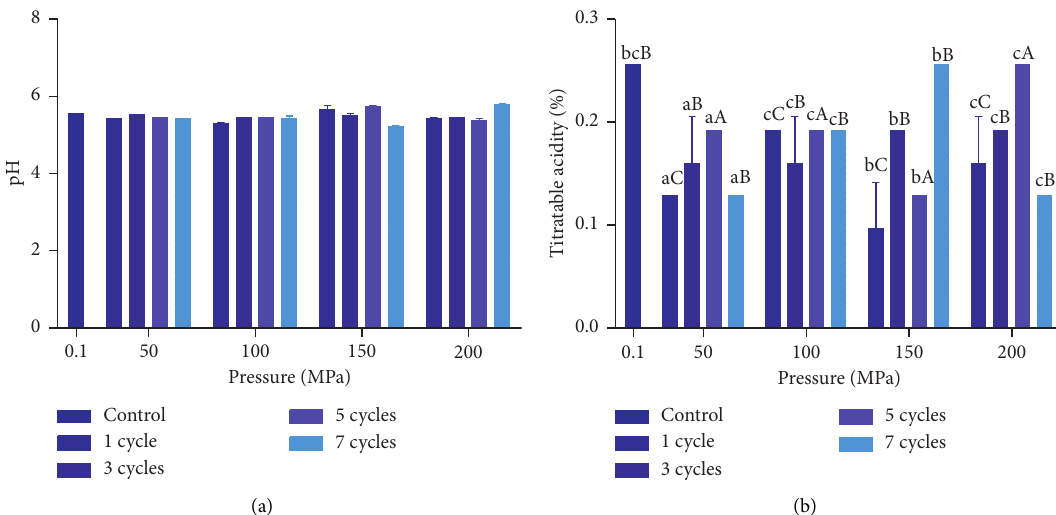
Figure 2: Effect of microfluidization on (a) pH and (b) titratable acidity. Post hoc test was not applied on pH values as ANOVA was found nonsignificant.